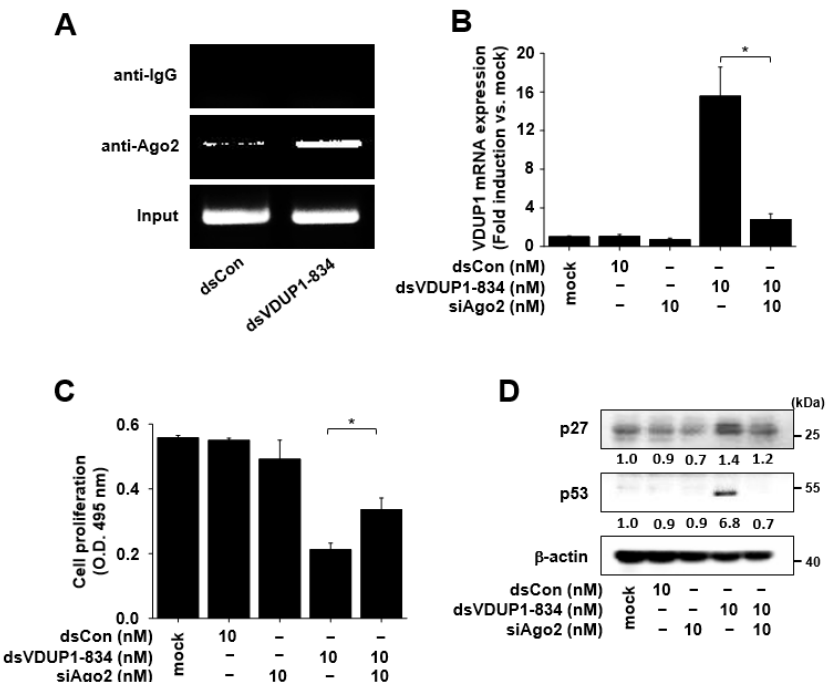
Figure 5. The effects of dsVDUP1-834 were attenuated by Ago2 siRNA in A549 cells. A549 cells were transfected with dsCon, dsVDUP1-834 (10 nM), or siAgo2 (10 nM) for 96 h. ( A ) ChIP assays were performed using control IgG or anti-Ago2 antibody to pull down associated DNA. The precipitated DNA was amplified by PCR using primer sets specific to dsVDUP1-834 target sites. ( B ) The mRNA expression of VDUP1 was analyzed by qRT-PCR. Data are represented as mean ± S.D of triplicate determinations. ( C ) Cell proliferation was measured by XTT assay. Data are represented as mean ± S.D of triplicate determinations. ( D ) Protein levels of p27, p53, and β -actin in total cell lysates were determined by Western immunoblot analysis. Normalized relative intensities are shown below the bands. * denotes that the response is significantly different from dsVDUP1-834-treated group as determined by Dunnett’s t -test at p < 0.05.